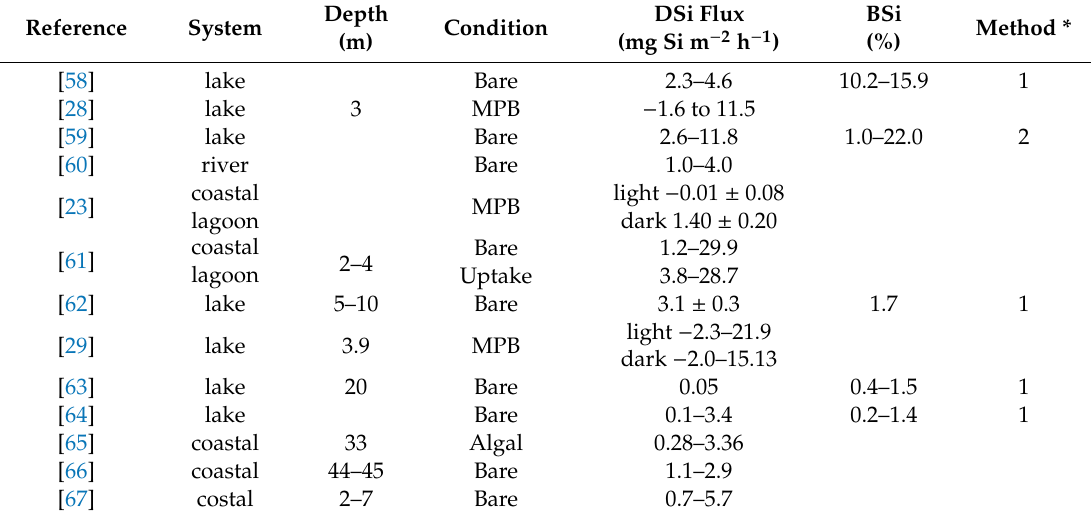
Table 6. Sedimentary DSi fluxes ( µ g Si m − 2 h − 1 ) and BSi content (%) in sediments of di ff erent